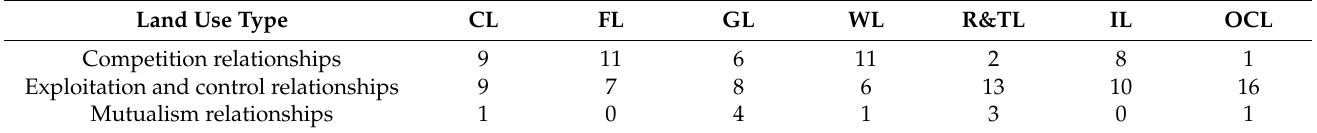
Table 6. Distribution of ecological